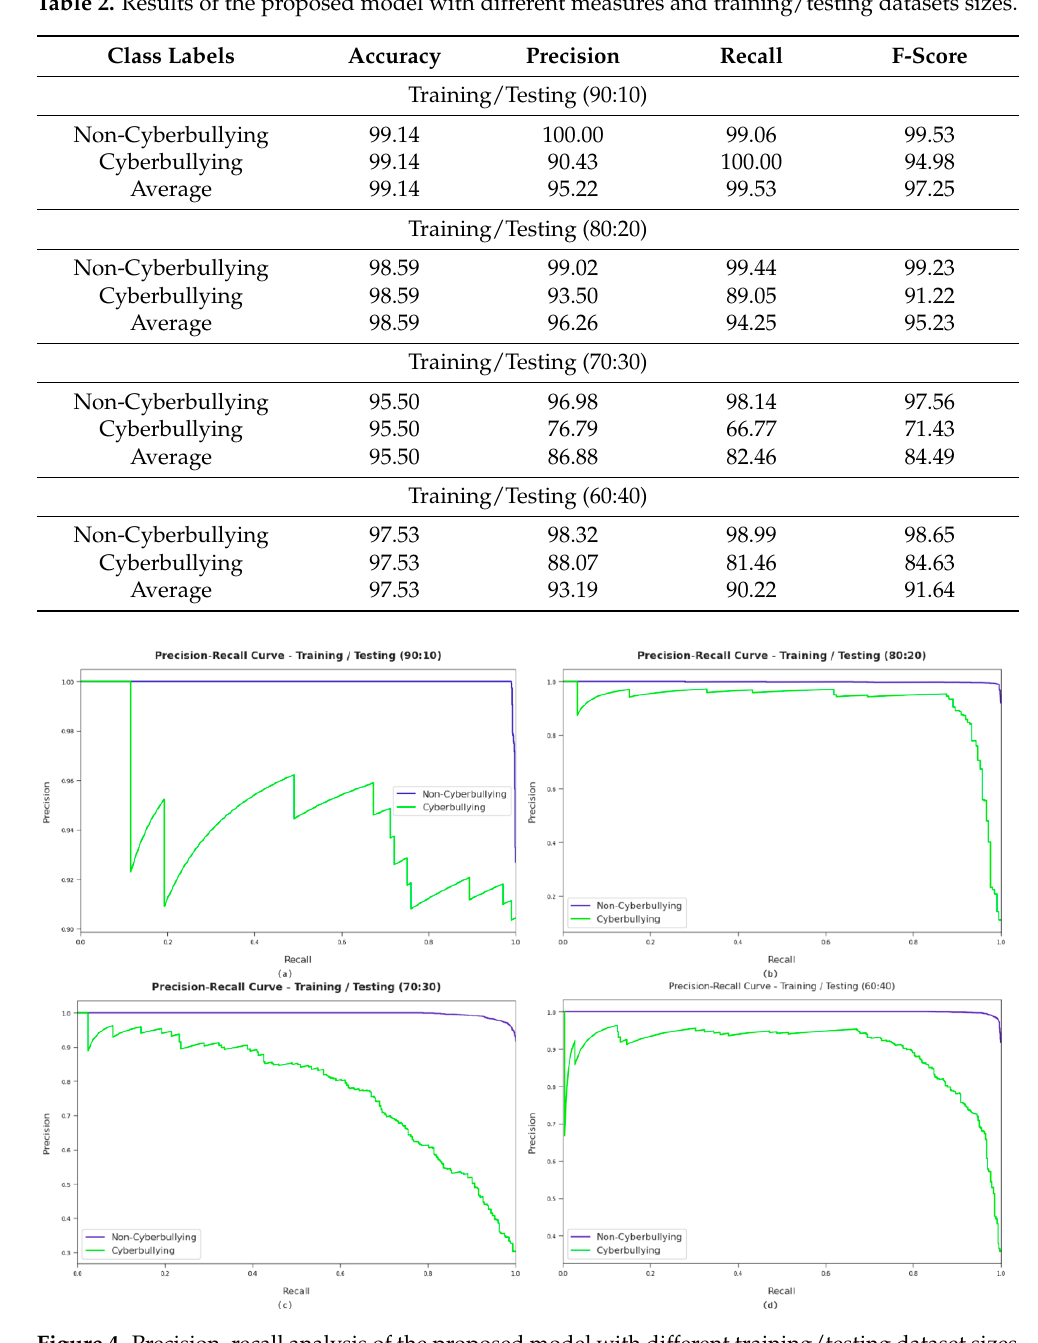
Figure 5. The ROC analysis of the proposed model with different training/testing dataset sizes. Where ( a ) considers 90:10 training/testing data split, ( b ) considers 80:20 training/testing data split, ( c ) considers 70:30 training/testing data split, and ( d ) considers 60:40 training/testing data split.